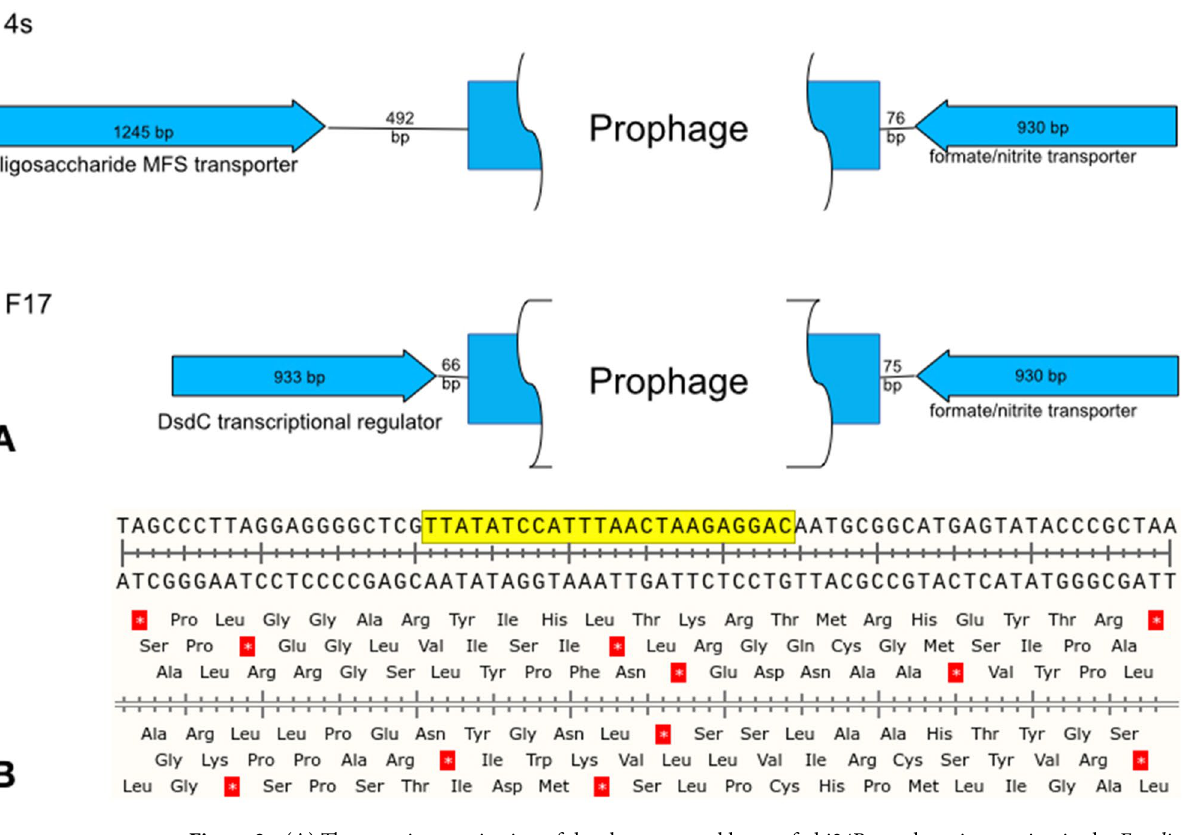
Figure 2. ( A ) The genetic organization of the chromosomal locus of phi24B prophage integration in the E. coli strains 4s and F17. ( B ) The nucleotide sequence of the conserved integration site. The yellow box—the sequence that is duplicated during the integration to flank the prophage in the